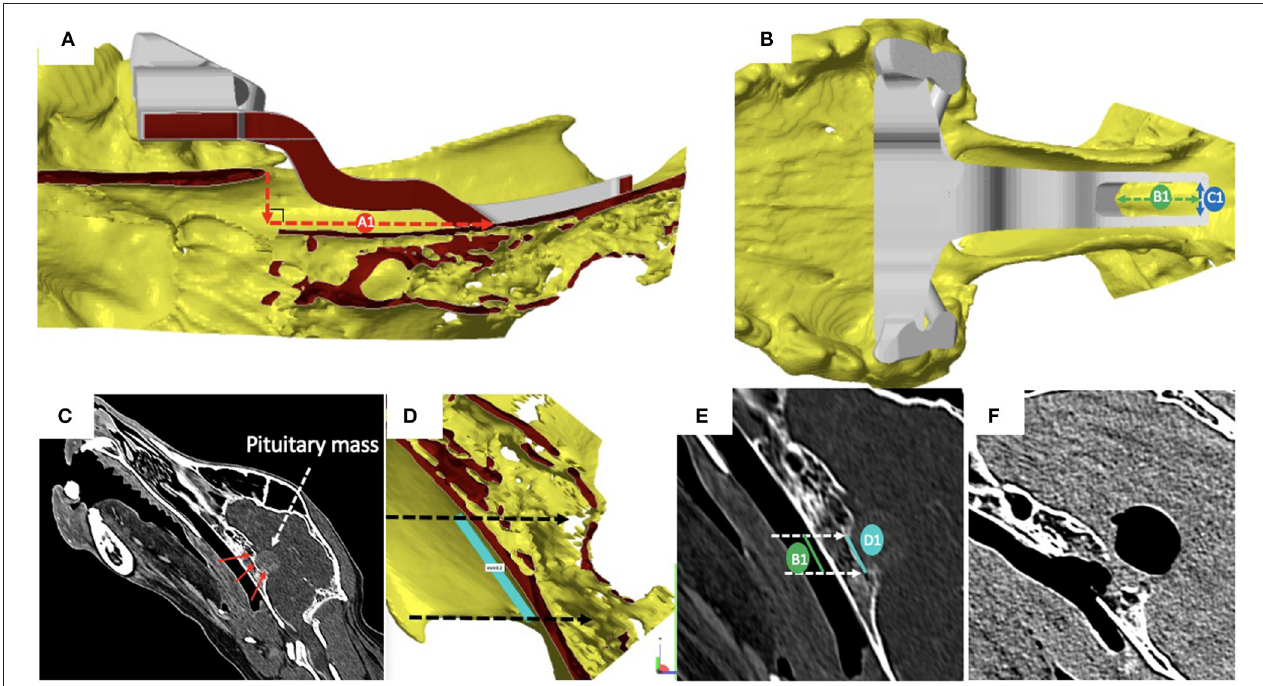
FIGURE 3 | (A) Sagittal section of the skull visualised with the CAD software Netfabb professional (rostral is to the left in the figure); cortical surfaces appear in yellow and the 3-dimensional printed guide in place is in grey: the distance between the vomer and the rostral aspect of the burring window depicted by the guide (A1) was measured by drawing a vertical line from the tip of the vomer to basisphenoid and another line, perpendicular to the first and extending to the rostral margin of the surgical guide; (B) dorsal view of the skull and surgical guide in place, visualised with the CAD software: the length (B1) and the width (C1) of the burring window into the basisphenoid first cortical bone layer appear as the green and blue double head dashed arrows, respectively; (C) the length of bone to remove from the inner cortical layer of the basisphenoid bone (red arrows) forming the sella turcica was defined to match that of the outer cortical layer to burr; (D) light blue line chosen to be no longer than the tuberculum sellae and the dorsum sellae ); (E) the length of inner and outer cortical layers to be removed where defined as equal; (F) sagittal reconstructed post-operative post-contrast CT image obtained to assess completeness of the hypophysectomy; note the signal void region suggesting presence of air.